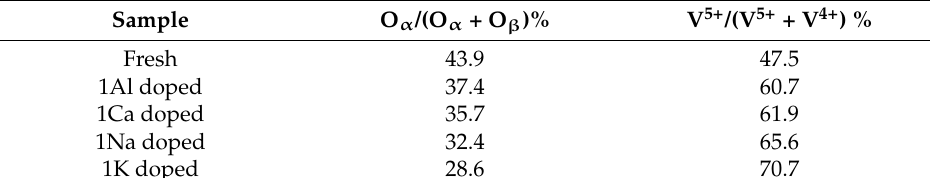
Figure 8. X-ray photoelectron spectroscopy (XPS) spectrum of O 1s ( a ) and V 2p ( b ) of fresh (1V-5W/Ti) and 1M doped catalysts (M = Al, Ca, Na, and K).